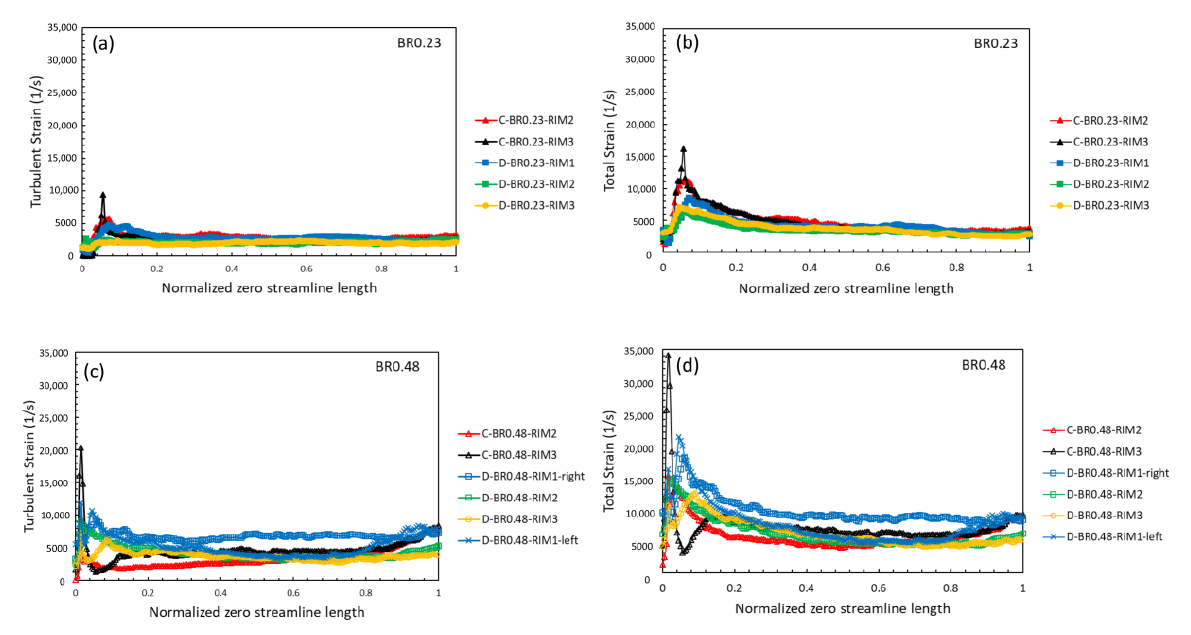
Figure 12. Turbulent ( a , c ) and total ( b , d ) strain profiles along zero-streamline for BR0.23 and BR0.48 baffles.